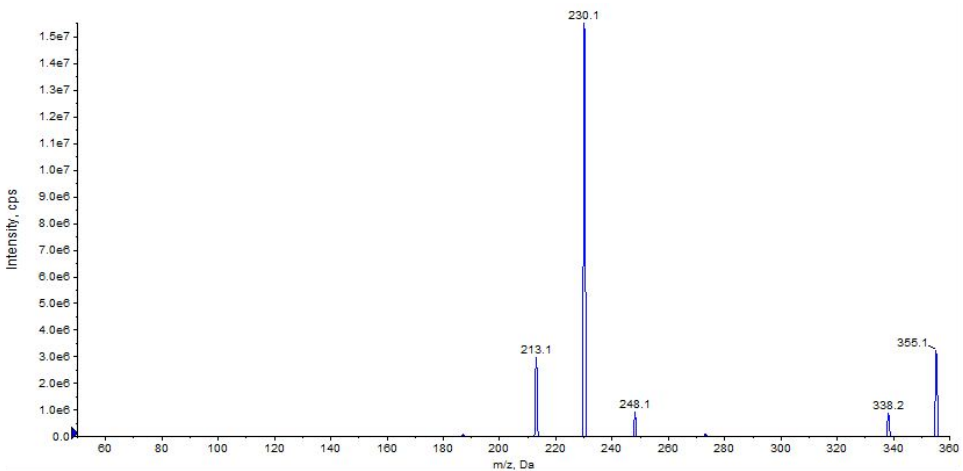
Figure 9 . Product ion scan of URB937 compound obtained by QqQ. Exponential scale to base 10. The ion at m / z 187, due to the loss of the carbamoyl group, is observed only at higher collision energies (figure not shown). In the case of URB937, the presence of [M 2 + Na] and [M 3 + Na] at m / z 731.3057 and 1085.4636, respectively, was observed by accurate mass (Figure 10).